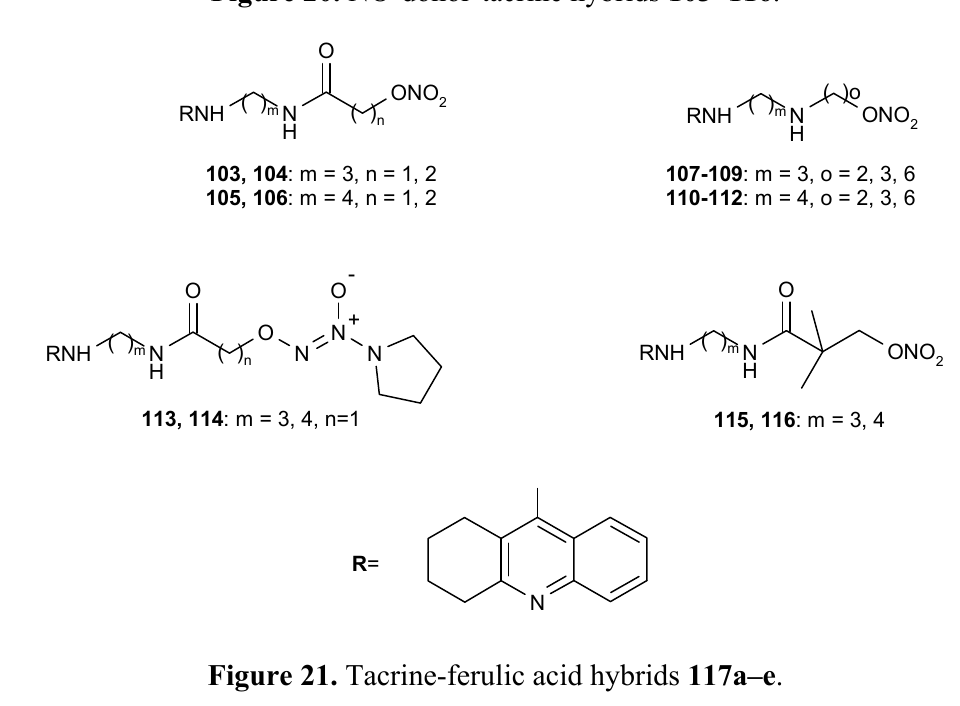
O OMe( ) n NNH 117a–e , n = 2–5, 8.